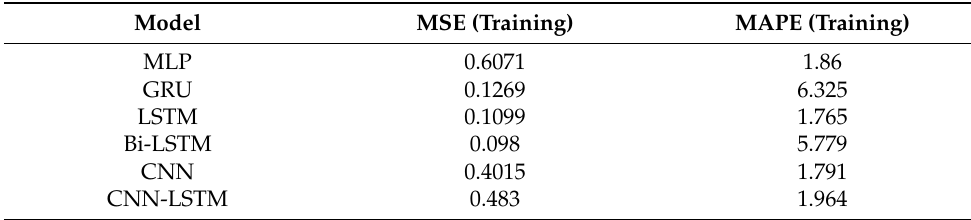
Table 5. The models’ training results using Tesla data with six input features.